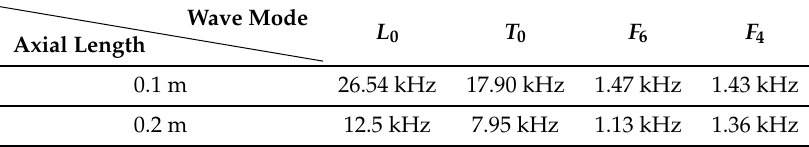
Table 2. Working frequency for second and third verification in Section